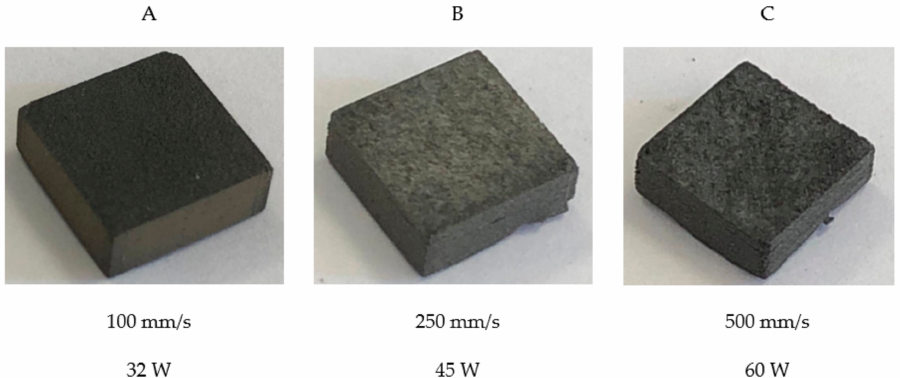
Figure 17. SiC samples printed using laser power and sintering speed, as predicted from the numeri- cal model, and zigzag scanning